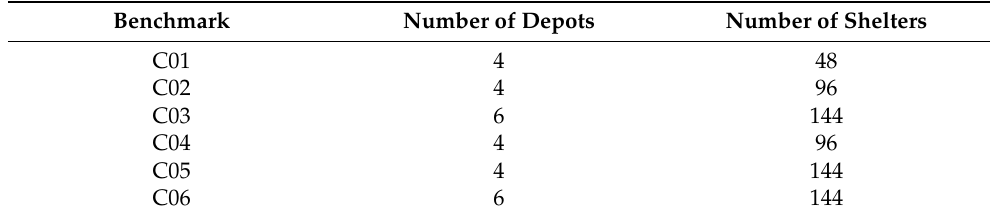
Table 2. Test data